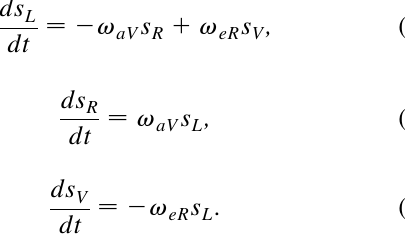
FIG. 3. The vertical spin component, s , normalized to 1, vs V time for the proton, assuming an EDM of 10 (cid:1) 18 e cm when the magic Wien filter is on, (cid:5) ¼ 0 . In red, the momentum is 0 : 7 GeV =c , and green 1 : 4 GeV =c . The EDM signal is the slope of the vertical spin component as a function of time. We show only two cases for clarity. The vertical oscillation is at the proton g - 2 frequency, which is an order of magnitude larger than the corresponding deuteron